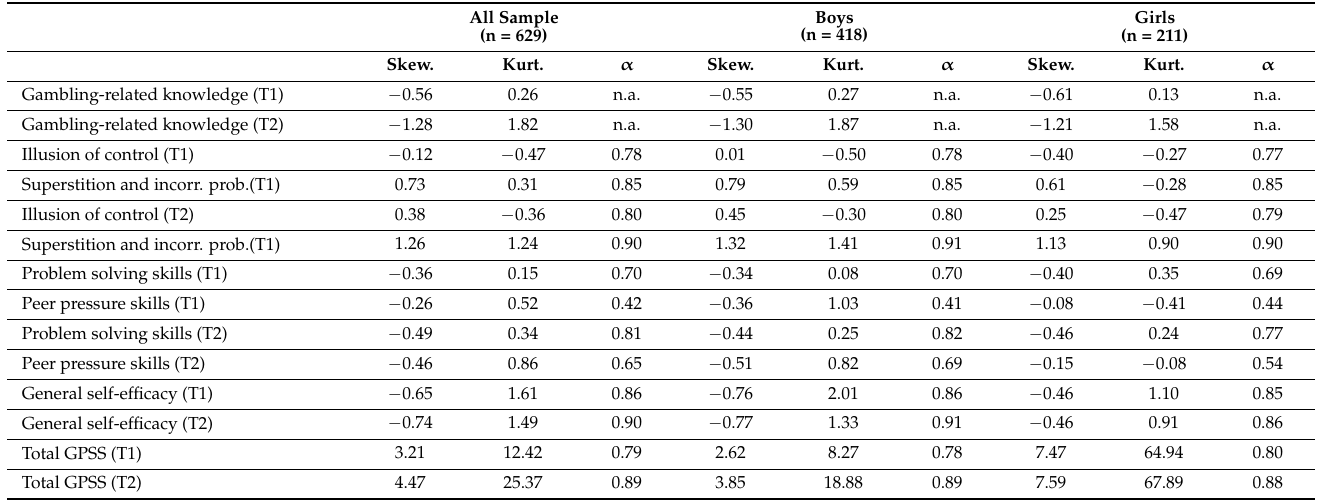
Table 2. Skewness, kurtosis and Cronbach’s alpha reliability for all variables (all sample- and